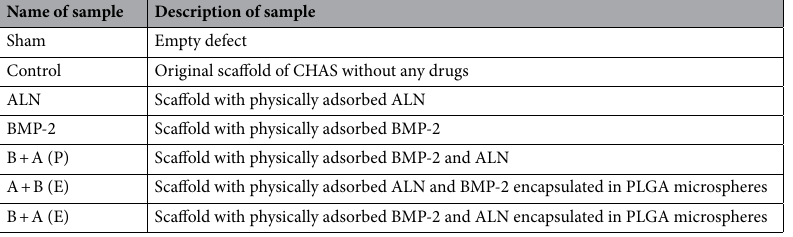
Table 1. Sample abbreviations used in this study.